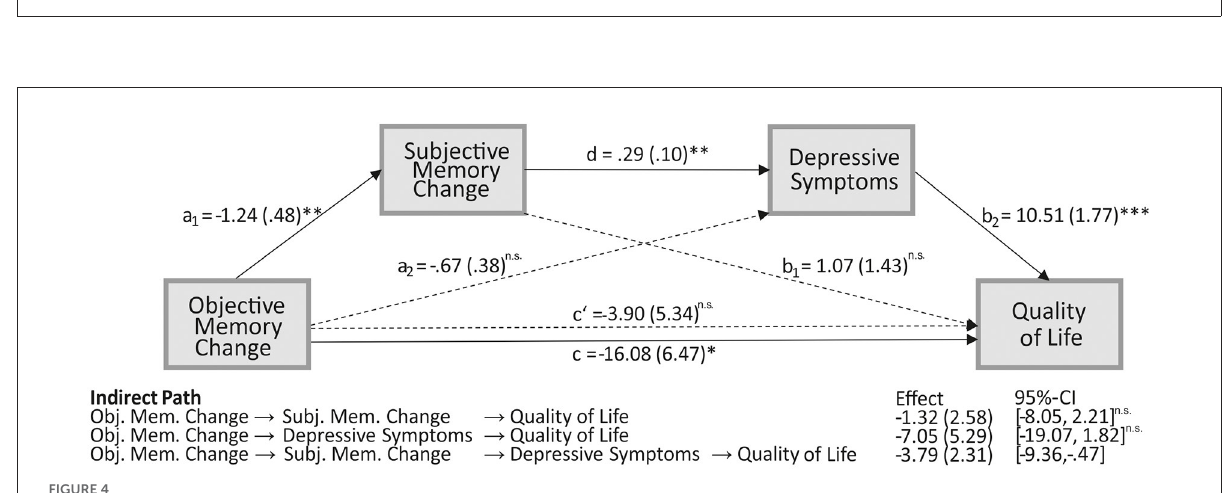
FIGURE4 The serial mediating effect of subjective memory change and mood in the relationship between objective memory change and quality of life (QoL). All presented effects are unstandardized; a n is the effect of objective memory change on mediators, objective memory decline is coded as 1 and no decline as 0; b n is the effect of mediators on QoL; c is the total effect of objective memory change on QoL; c’ is the direct effect of objective memory change on QoL after controlling for subjective memory change and depressive mood; d is the effect of subjective memory change on mood. * p < 0.05, ** p < 0.01; *** p < 0.001; ns, non-significant; obj., objective; subj., subjective; mem.,